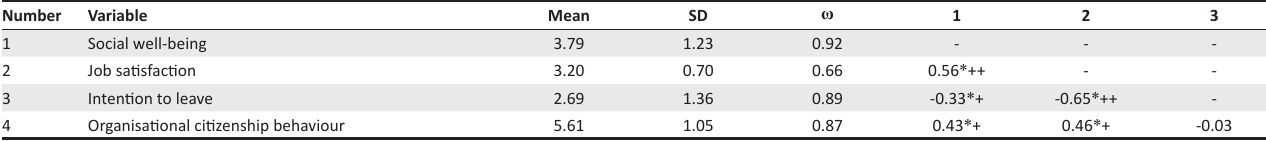
TABLE 2: Descriptive statistics, reliabilities and correlations of the scales. Number